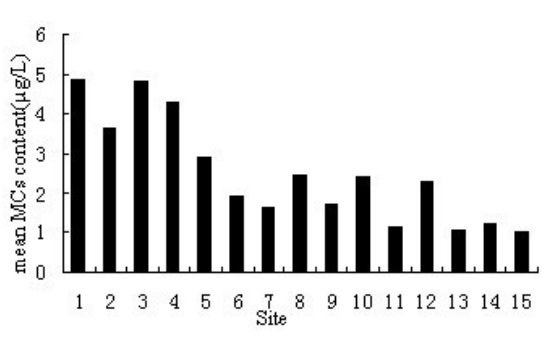
FIGURE 9. Annual mean MC concentrations in each sampling site (cf. map in Fig.